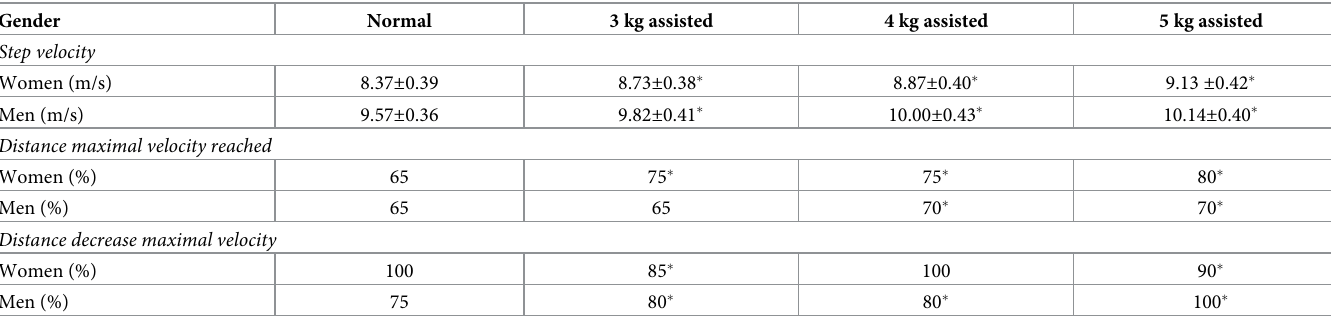
100 Men (%) 75 80 � 80 � 100 � � indicates a significant difference with the normal 60m condition on a p < 0.05